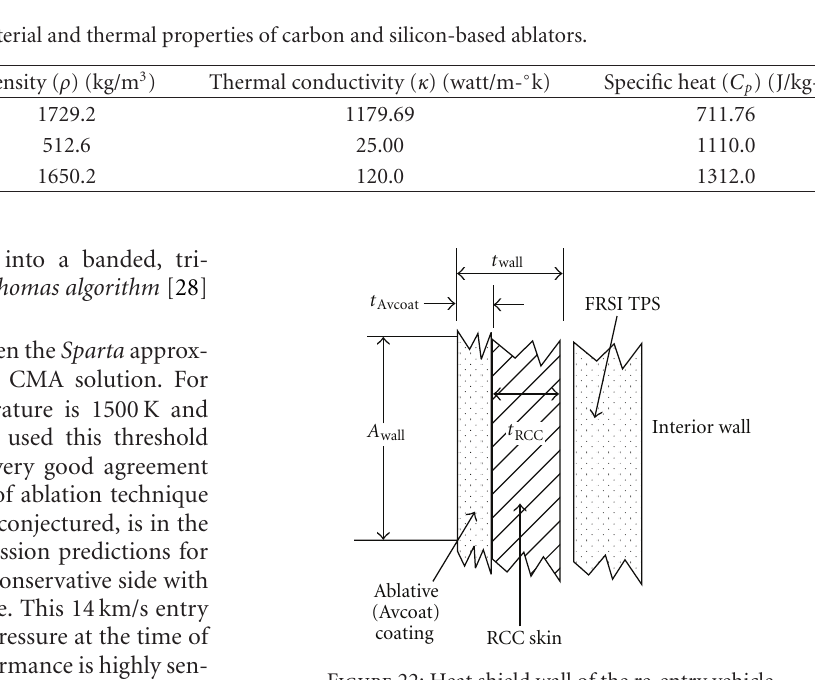
Figure 22: Heat shield wall of the re-entry